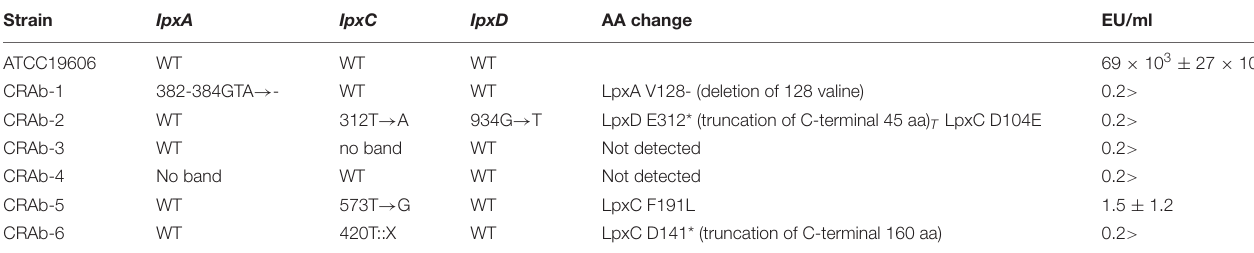
TABLE 1 | Lpx mutation analysis and limulus amebocyte lysate (LAL) assay of colistin-resistant Acinetobacter baumannii (CRAb) strains.